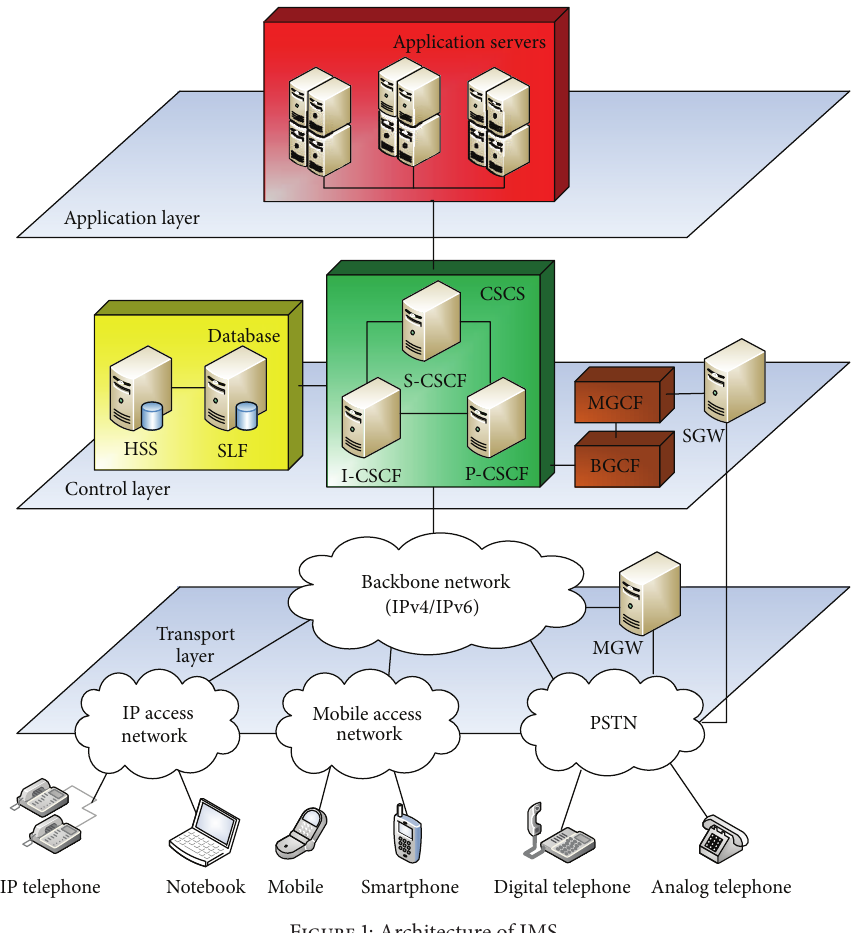
Figure 1: Architecture of IMS.